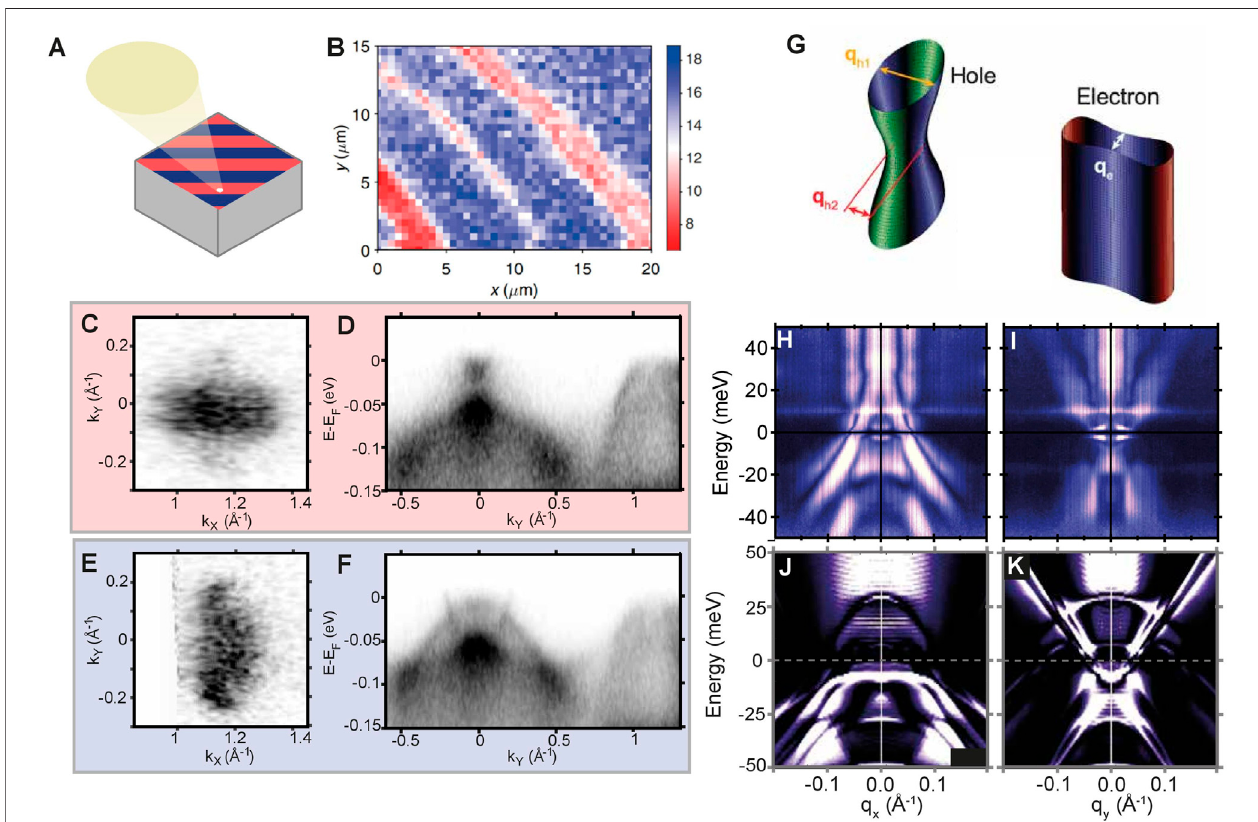
FIGURE 5 | Electronic structure within a single domain without the application of uniaxial strain. (A) Sketch of a NanoARPES measurement, where the beam is focusedtohaveacrosssection < 1 μ m. (B) ExperimentalspatialmapofFeSewherethecolourcorrespondstotheorthorhombicdomainsofFeSe,reproducedfromRef. [41]. (C,D) Fermi surface around the electron pocket ( h ] = 56 eV, 30 K) and A y − Z cut taken within a single orthorhombic domain [41]. (E,F) Fermi surface around the electronpocketand A y − Z cuttakeninanadjacentorthorhombicdomain[41]. (G) SketchoftheFermisurfacescatteringvectorsinferredfromSTMmeasurements, as suggested by Ref. [42]. (H,I) STM measurements of the QPI scattering dispersions as a function of energy along the q x and q y high symmetry axes respectively, reproduced from Ref. [42]. (J,K) Simulated QPI scattering dispersion from a model of FeSe which described the band structure shown in Figure 3 , from Ref. [82]. (G – I) are reproduced under the Creative Commons Attribution 4.0 International License.